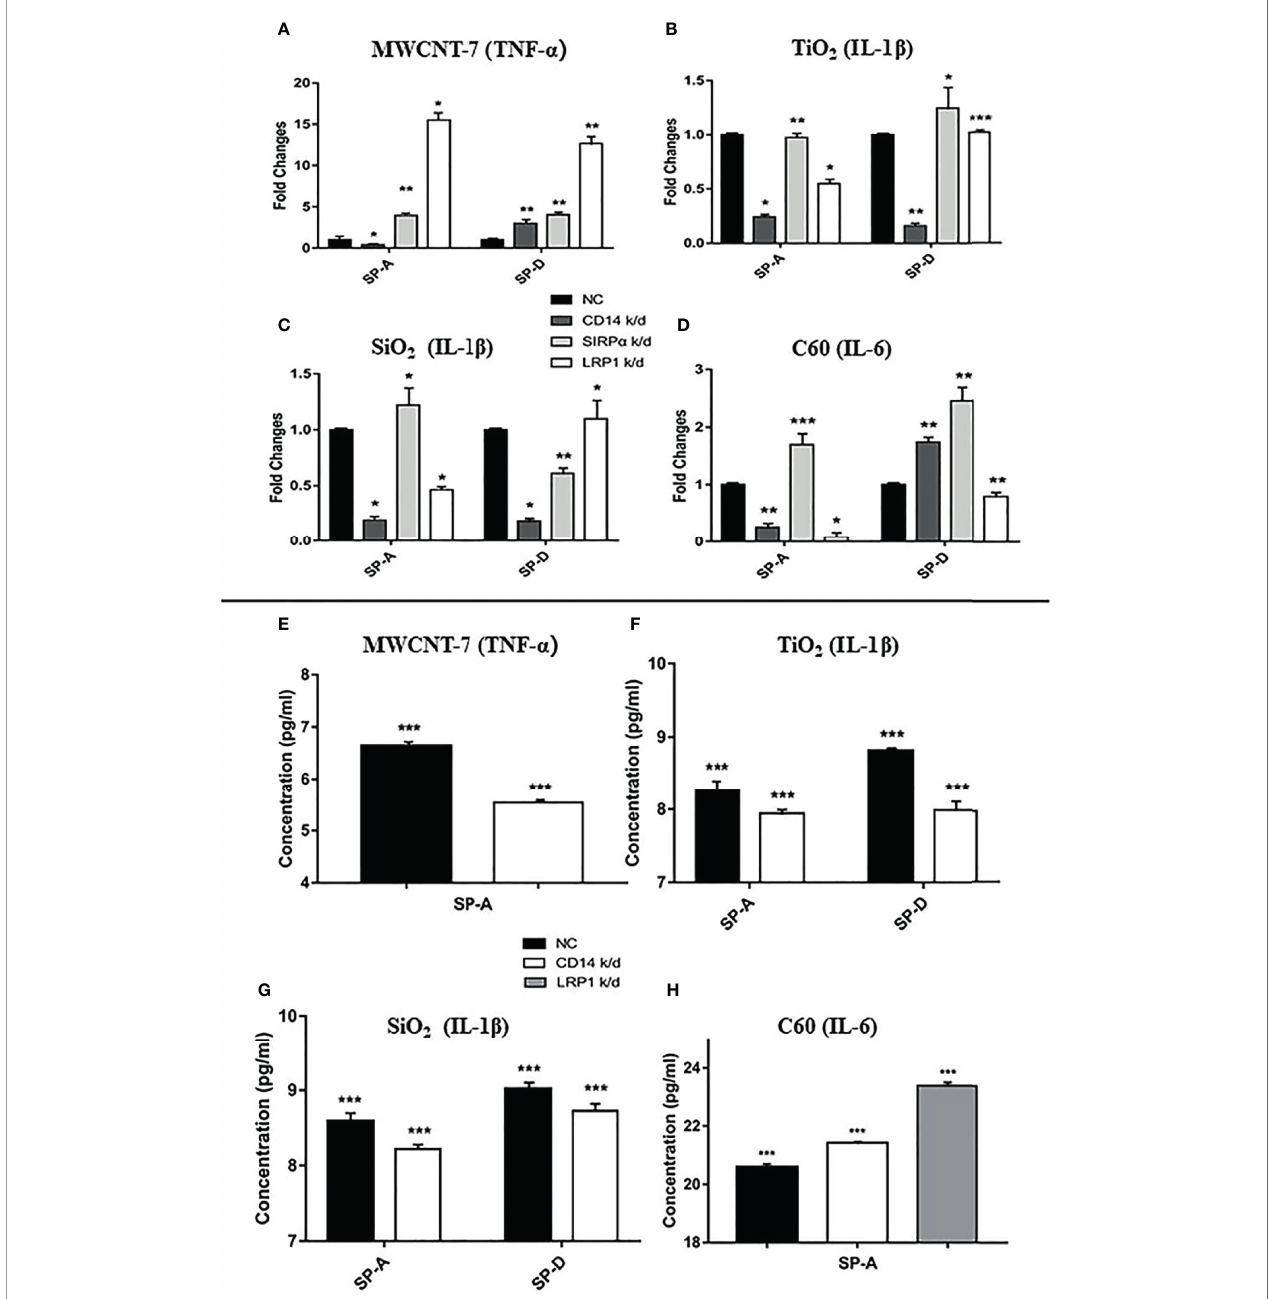
FIGURE 5 | Effect of LRP1, CD14, and SIRP a knockdown on cytokine production. Expression of LRP1, CD14, and SIRP a in rat primary alveolar macrophages was knocked down (k/d) by gene-speci fi c siRNAs. Macrophages were then treated with the vehicle; or 1 m g/ml MWCNT-7, TiO 2 , SiO 2 , or C60; or 1 m g/ml MWCNT-7, TiO 2 , SiO 2 , or C60 pre-incubated with 1 m g/ml of recombinant human SP-A, SP-D, or 10% concentrated BALF, and cultured for 12 hours. The cells were harvested for RNA isolation and qPCR analysis (A – D) and the culture supernatants were collected for ELISA (E – H) . (A, E) detection of TNF- a in MWCNT treated cells; (B, F) detection of IL-1 b in TiO 2 treated cells; (C, G) detection of IL-1 b in SiO 2 treated cells; and (D, H) detection of IL-6 in C60-treated cells. *, ** and *** p values less than 0.05, 0.01, and 0.001, respectively, compared with the negative control